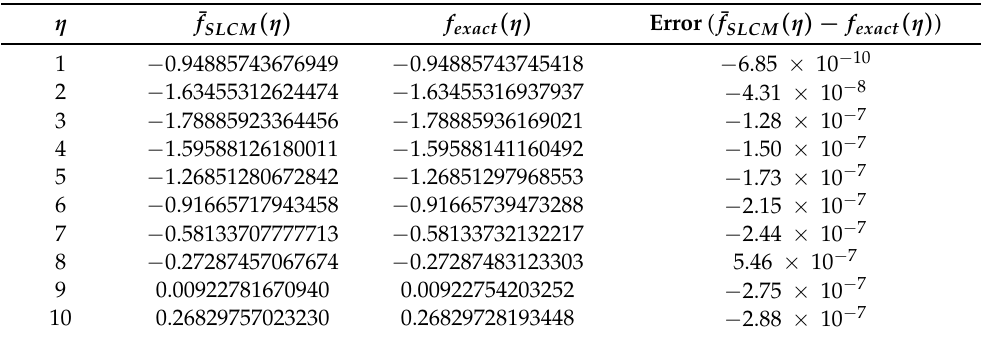
Table 4. Estimations of error for f ( η ) for λ = − 1 (injection) by setting S = − 1.0, M = 0.0, φ s 1 = 0.0, φ s 2 = 0.0, Ec = 0.0.